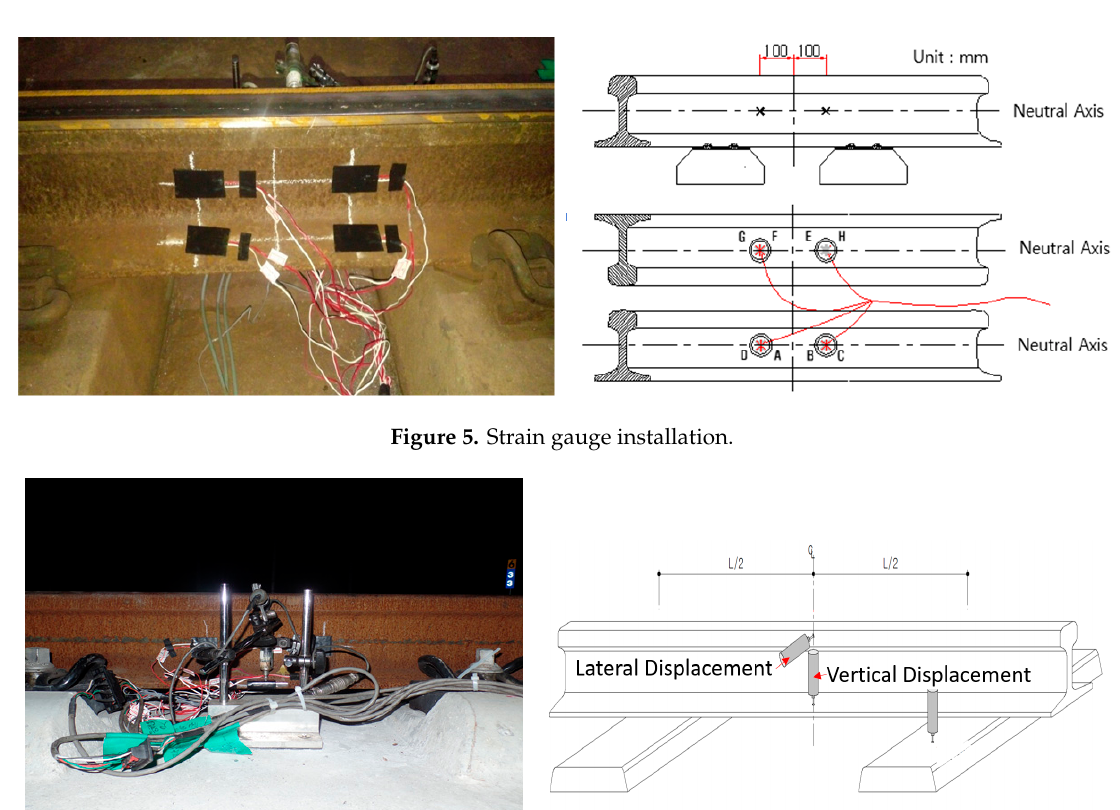
Table 6. Vehicle specification for trackside measurement.